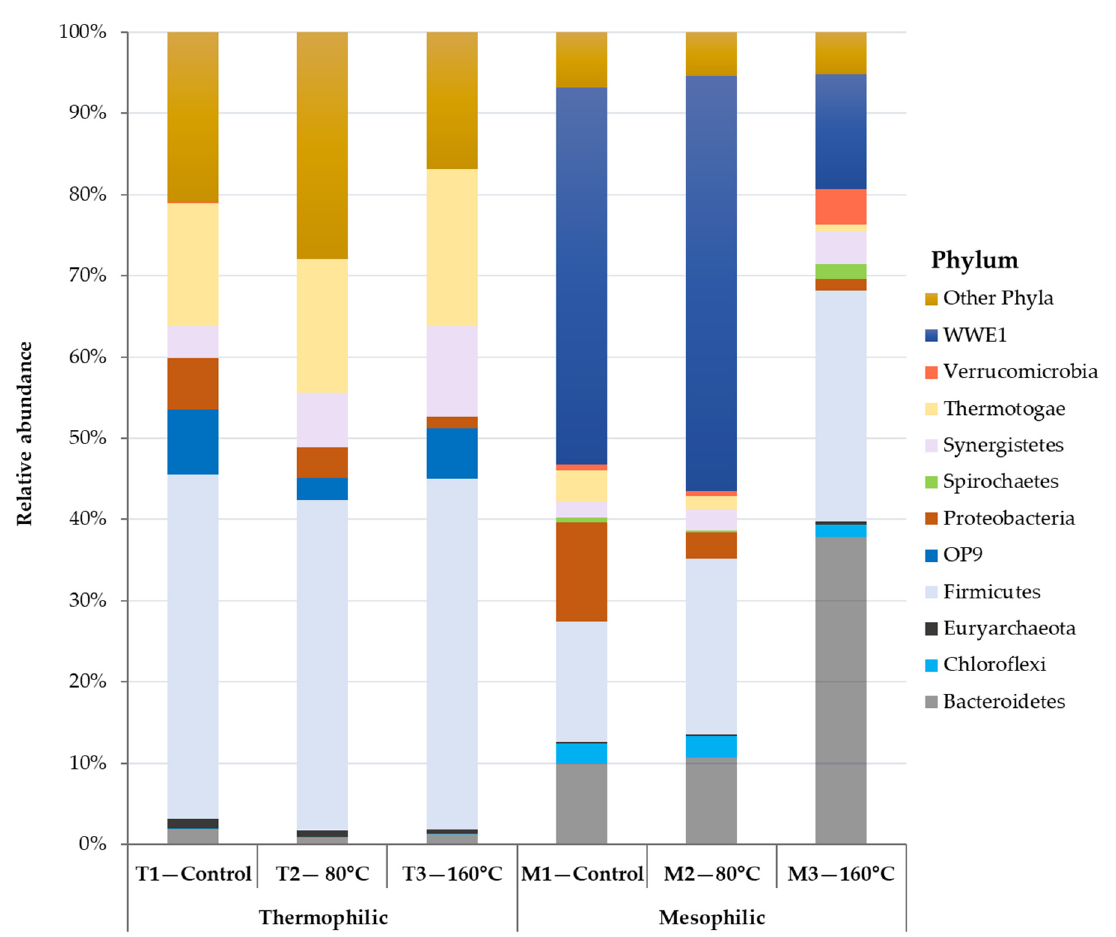
Figure 4. Taxonomic classification of the most abundant bacterial and archaeal phyla found in the mesophilic and thermophilic digesters (Phyla that were more abundant than 1% in either one of the mesophilic or thermophilic digesters effluents’ samples were plotted. Phyla that accounted for <1% of the total population were grouped into “Other Phyla”.).